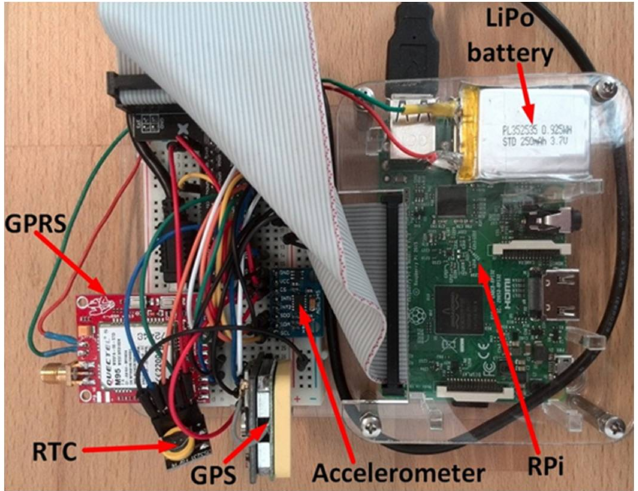
Figure 6. The OMCU